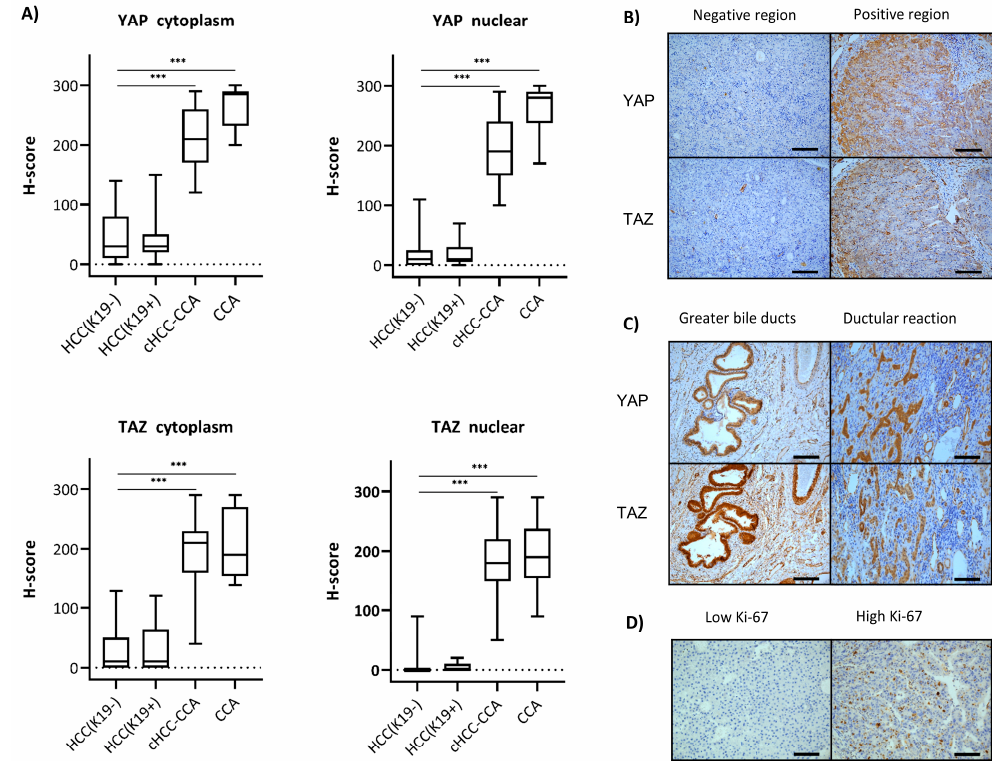
Figure 2. The histoscores (H-scores) of HCC K19 − , HCC K19 + , cHCC-CCA, and CCA were plotted ( A ). Statistically significant differences in YAP and TAZ expression in the cytoplasm and nucleus were observed between the HCC groups, cHCC-CCA, and CCA (*** p < 0.001). Intratumoral heterogeneity is illustrated in a representative example of an HCC K19- case ( B ). Regions with and without YAP and TAZ were observed in this case. Expression of YAP and TAZ in all compartments of the biliary tree was observed ( C ). Illustration of two HCC cases with a low and high proliferation index (Ki-67) ( D ). All images were taken at 20×. Scale bar: 100 µm.